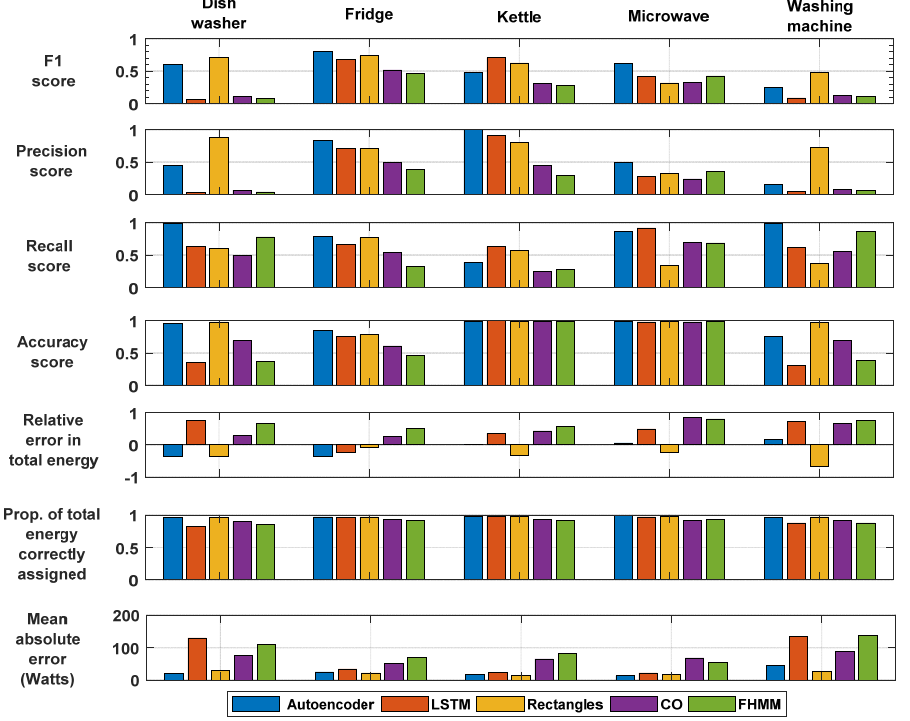
Figure 7. Energy disaggregation performance analysis for home seen during training.